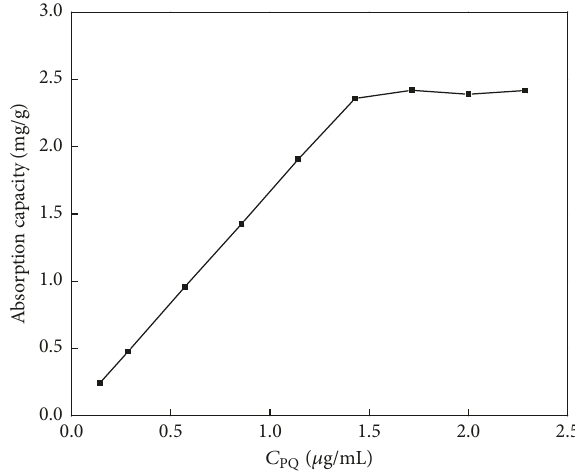
Figure 4: The adsorption capacity of Fe 3 O 4 @SiO 2 MNPs.